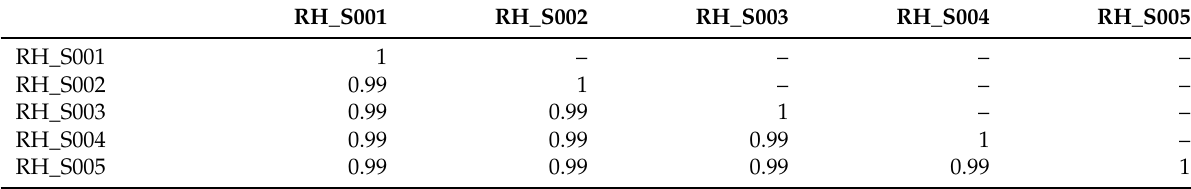
Table 2: Spearman correlation between functional profiles a of CAMI